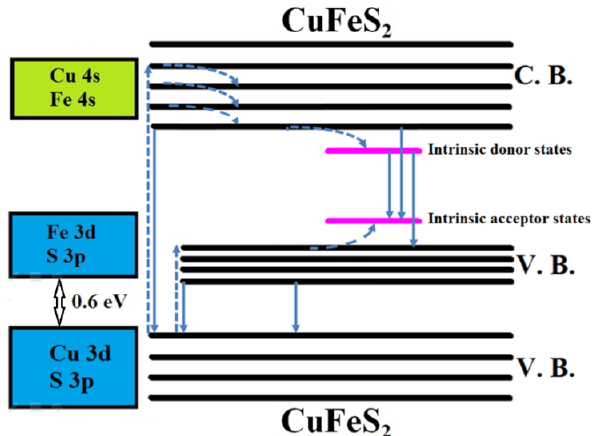
Fig. 6. Schematic of the possible optical absorption spectra and relaxation pathways of synthesized CuFeS 2